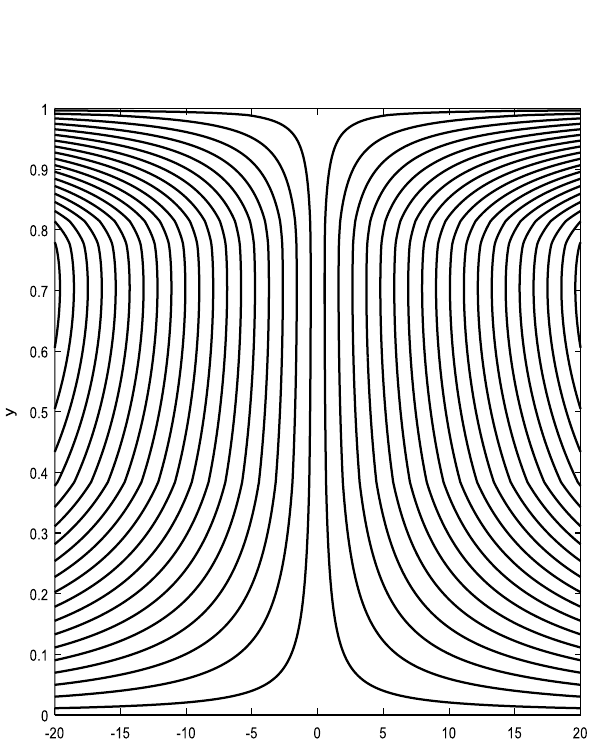
Figure 41. Stream lines profile at F = 0.6 and Ω =